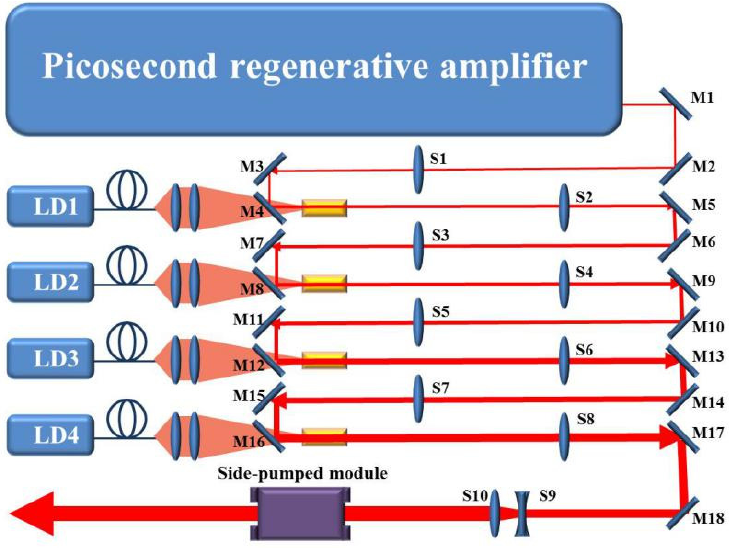
Figure 7. Diagram of the hybrid amplifier. M1–M3, M5–M7, M9–M11, M13–M15, M17–M18: Plane high-reflection mirrors; M4, M8, M12, M16: Plane high-reflection pump mirrors; S1–S8, S10: Plane-convex lens; S9: Plane-concave lens.